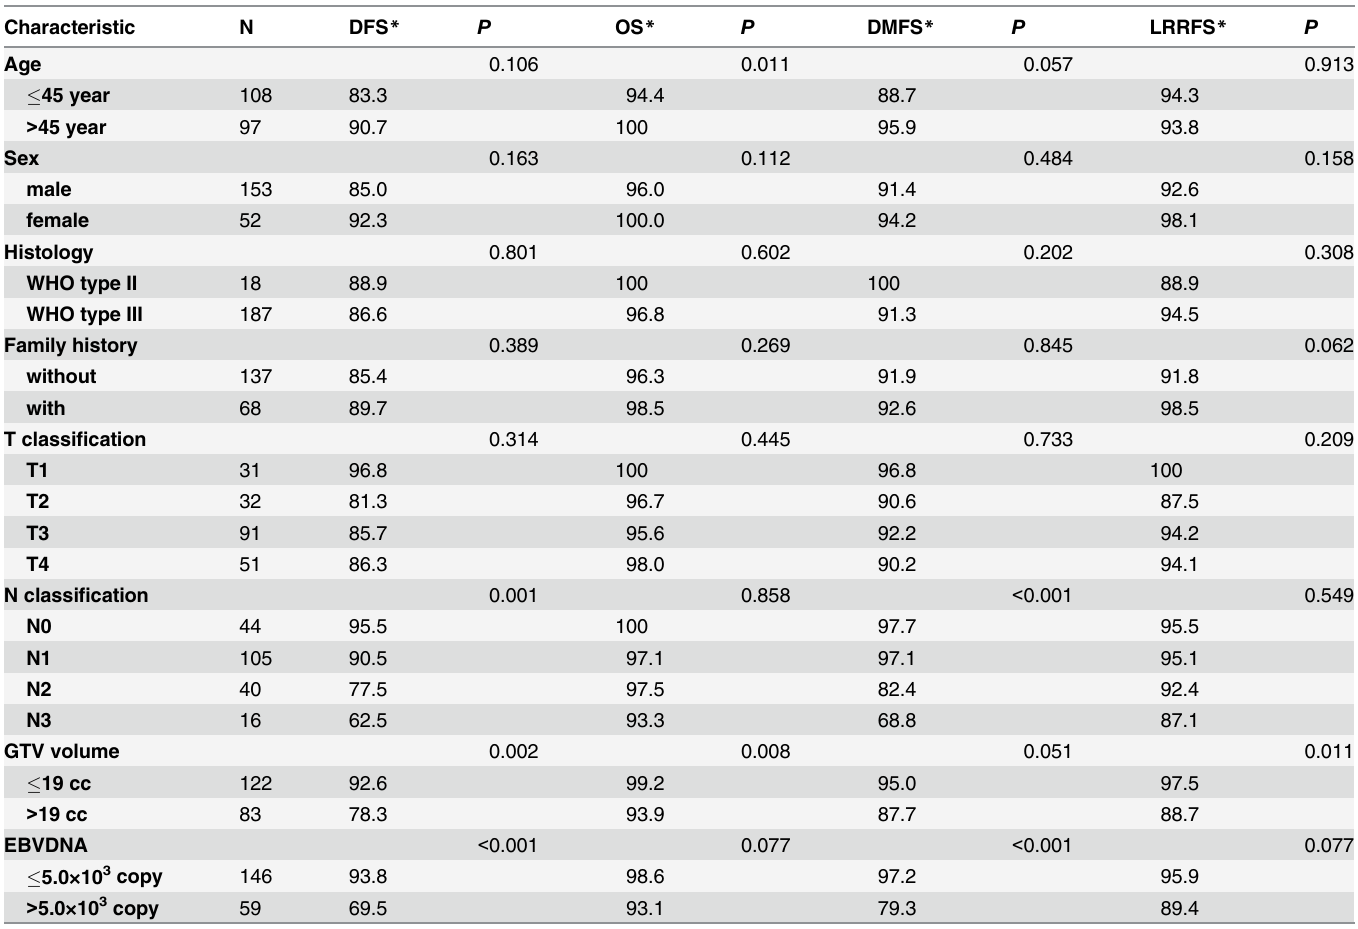
Table 4. Univariate analysis for various clinical